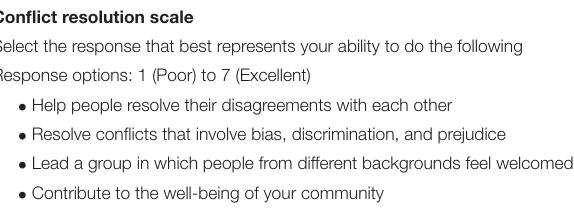
TABLE 1 | Select civic engagement items and scale information. Conflict resolution scale